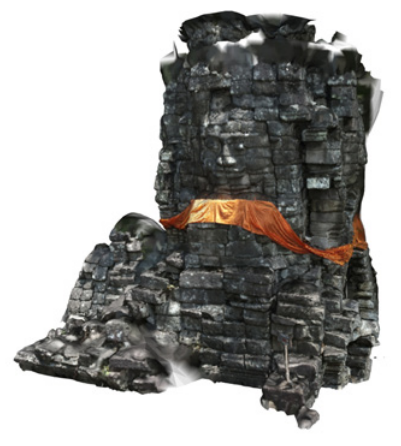
Figure 8: Model of the tower 18, Banteay Chhmar, Cambodia.